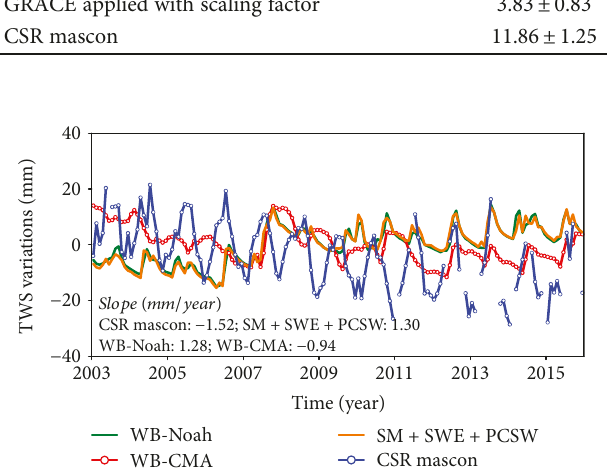
Figure 8: Comparisons of monthly TWS variations from water budget method and GRACE during the period of January 2003 to December